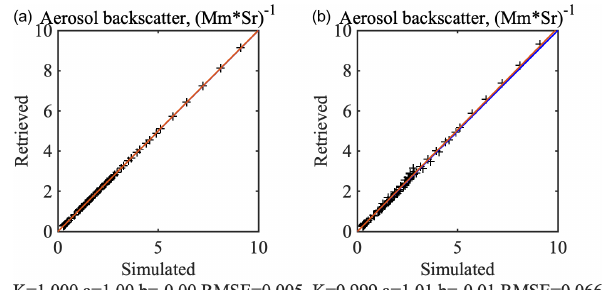
Figure 21. Comparison between simulated and retrieved aerosol backscatter profiles at 455 and 940nm combined in noise-free (a) and noisy (b)